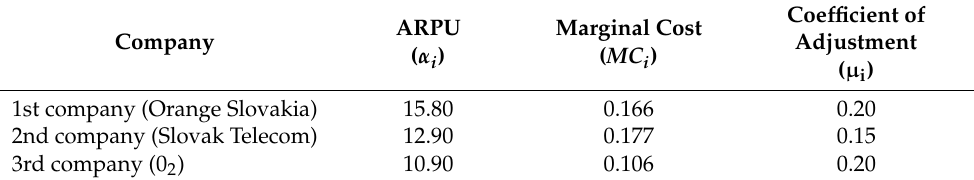
Table 1. Exogenous variables.